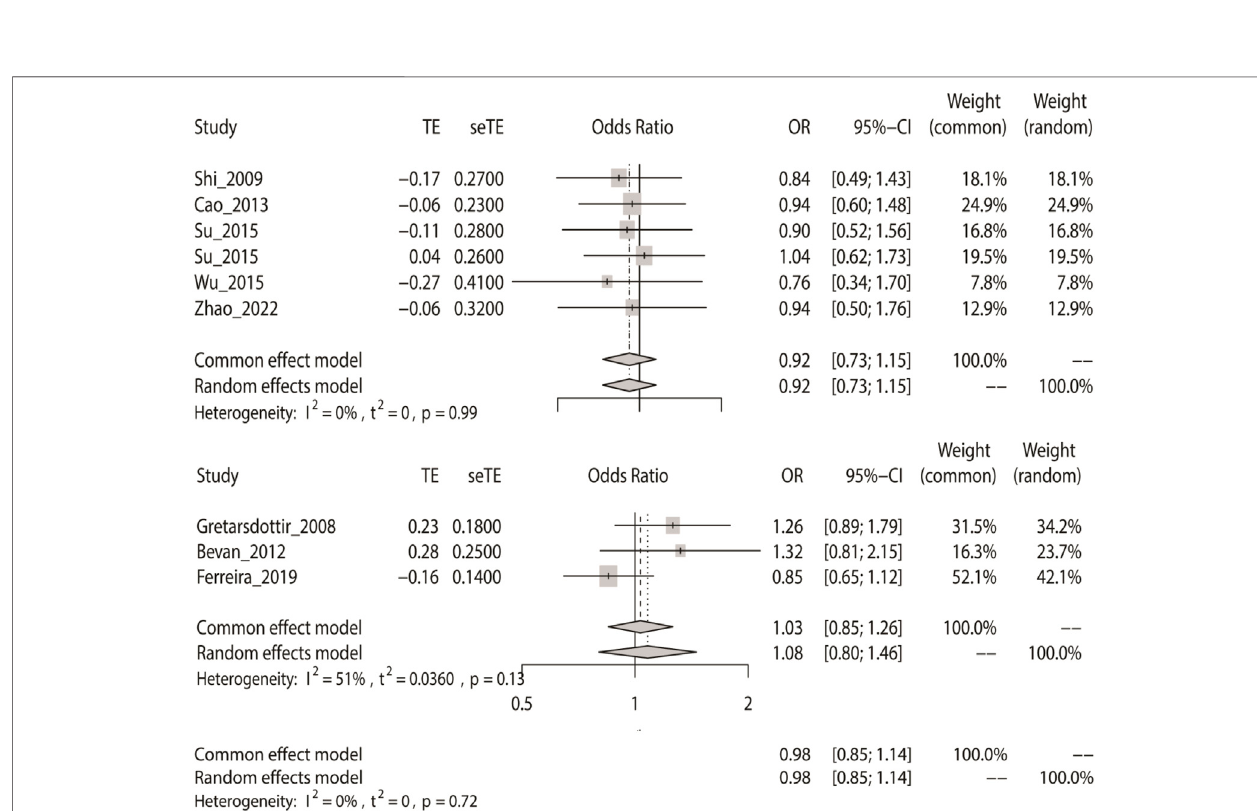
FIGURE 2 | Fixed-effect meta-analysis of the allele model for rs2200733 and rs6843082 in the Asian, non-Asian, and pooled populations.